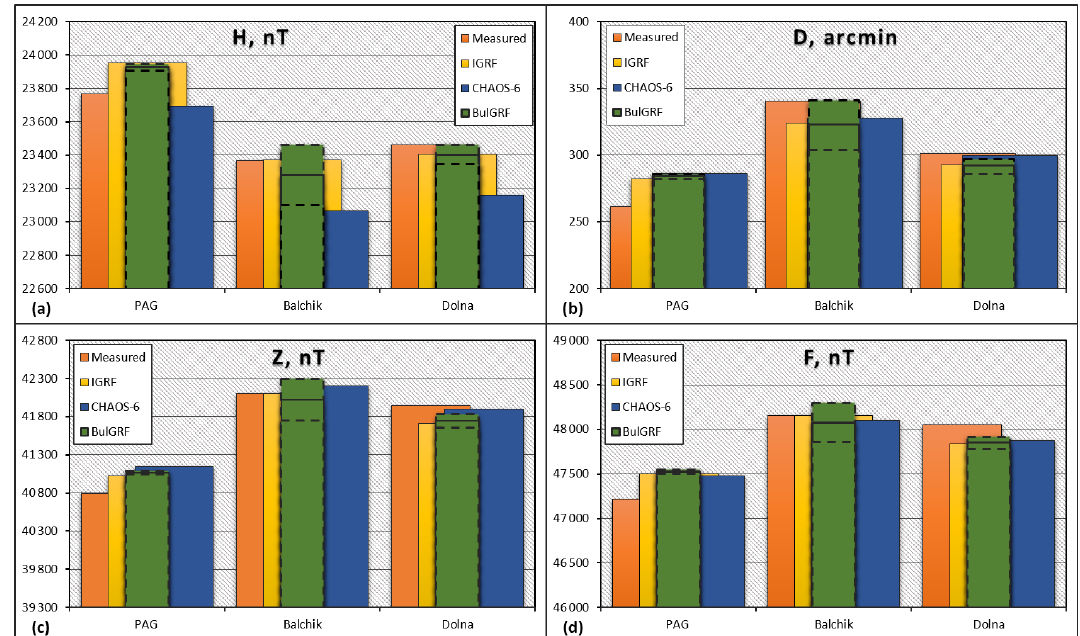
Figure 6. Values of the BulGRF model epoch 2015.0 together with the calculated confidence interval (dashed line), IGRF-12 and real data of (a) H (nT); (b) D (arcmin); (c) Z (nT); (d) F (nT) for PAG observatory, Balchik airport, and Dolna